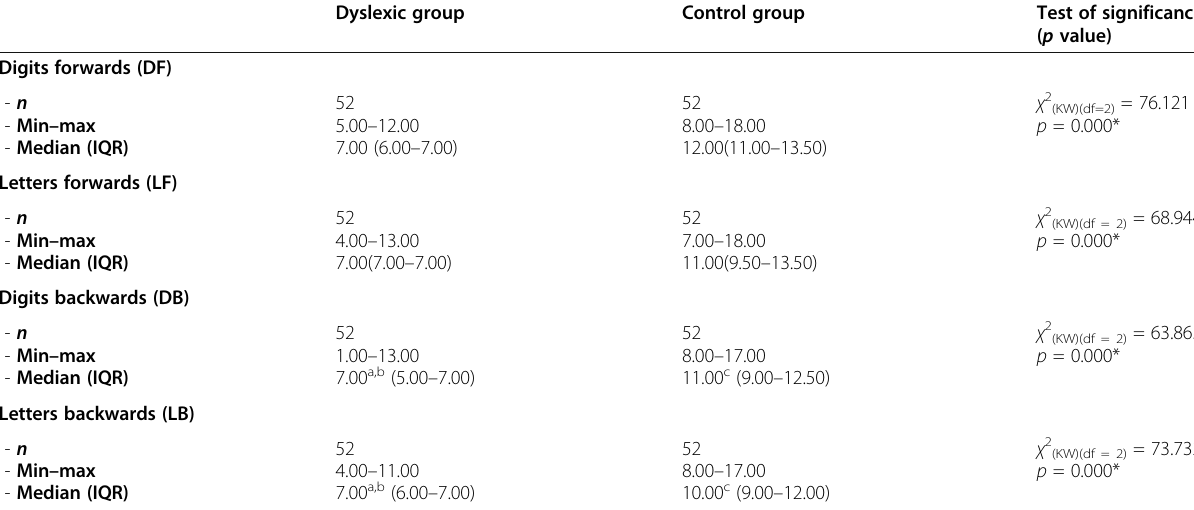
Table 2 Comparison between the studied groups as regards supplementary (verbal subsets) Dyslexic group Control group Test of significance